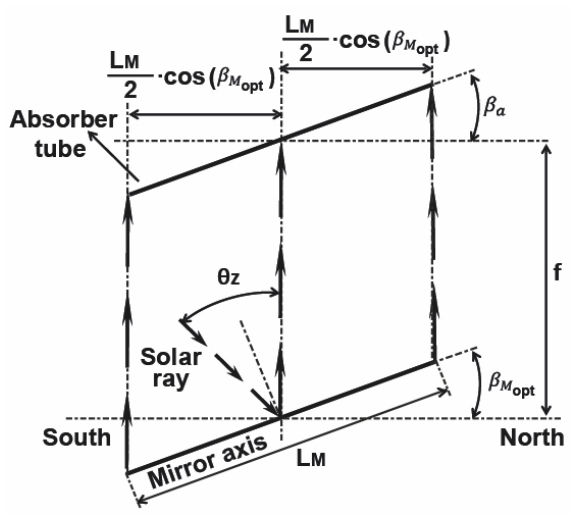
Figure 5. Case with µ =